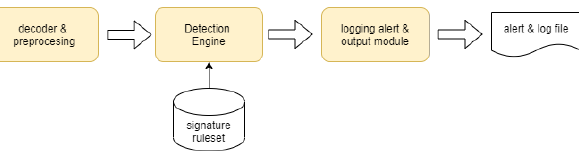
Figure 1. Main components of a typical